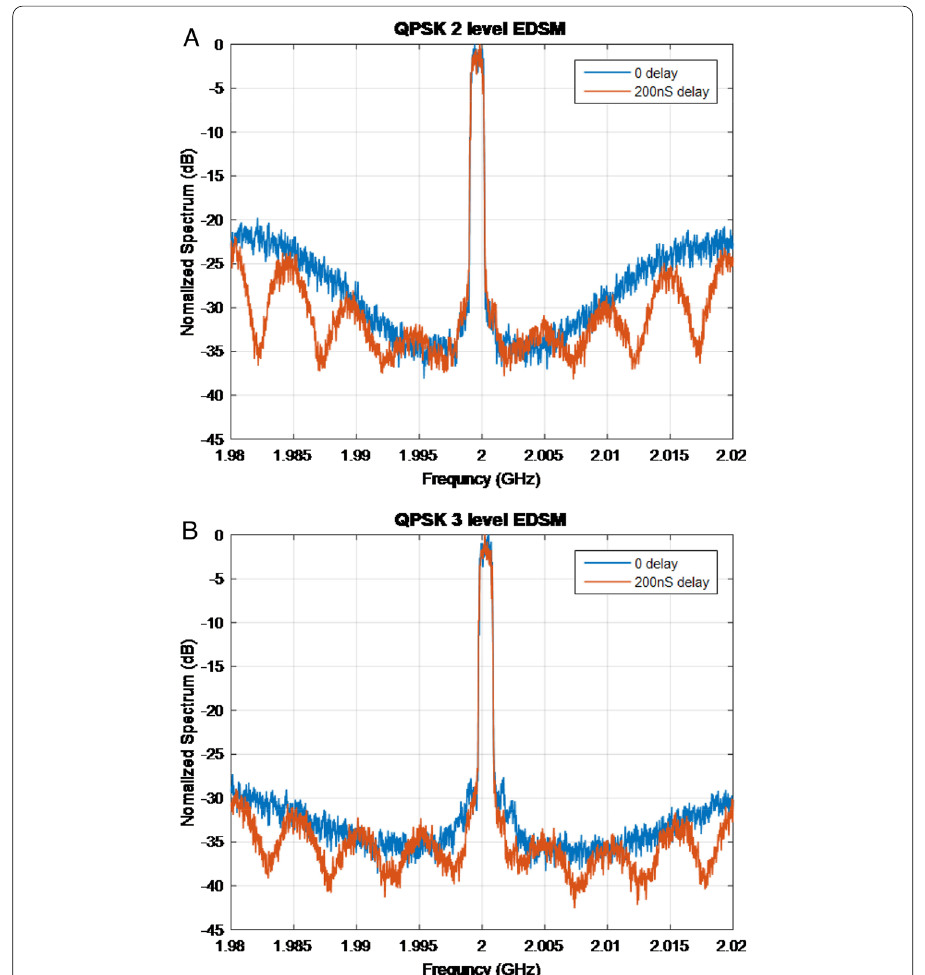
Fig. 18 Measured spectrum of two combined PLM PA units with QPSK signal. a Spectrum of 2 level EDSM with and without CANE. b Spectrum of three-level EDSM with and without